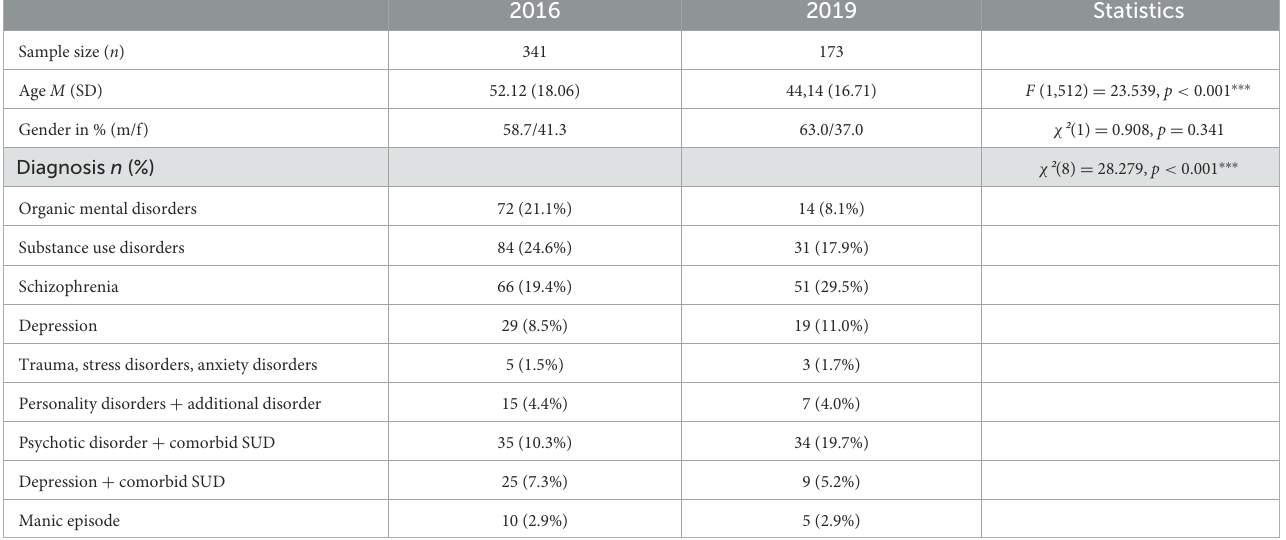
TABLE 1 Sample characteristics.